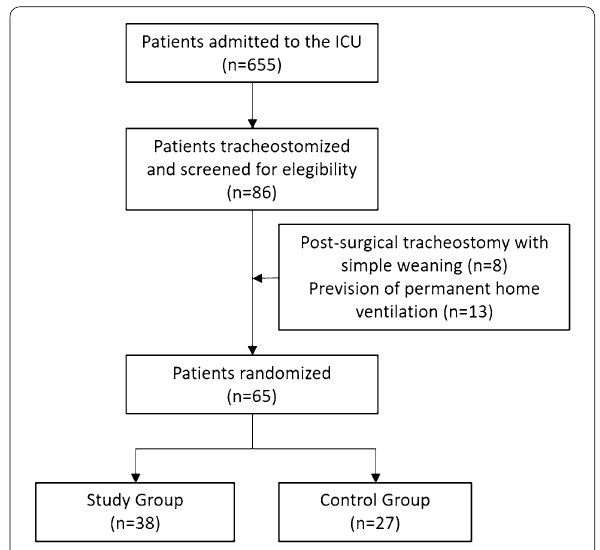
Fig. 2 Patients flowchart. ICU intensive care unit. Post-surgery indi- cates patients receiving tracheostomy for surgical reasons (i.e., after maxillo-facial or head–neck surgery)